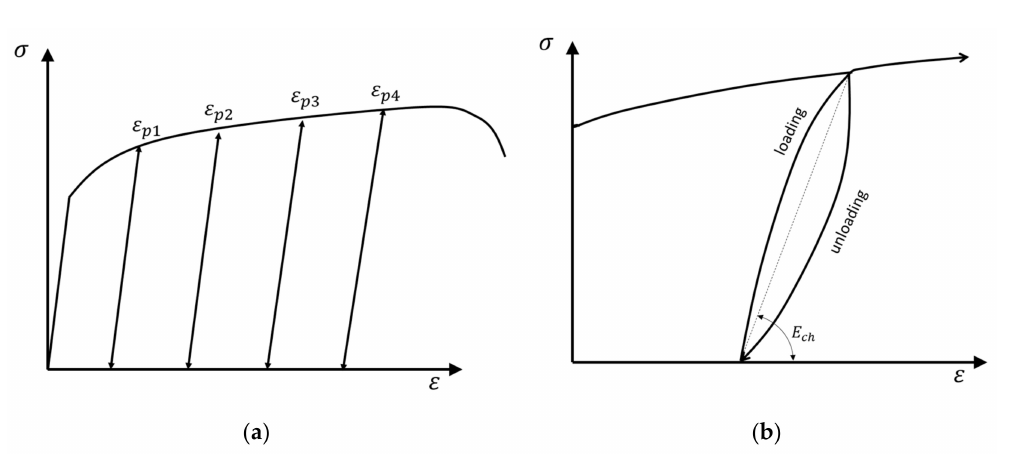
Figure 3. Schematic representation of the elastic modulus degradation testing in where: ( a ) loading–unloading test and ( b ) a hysteresis loop observed during the elastic unloading–loading